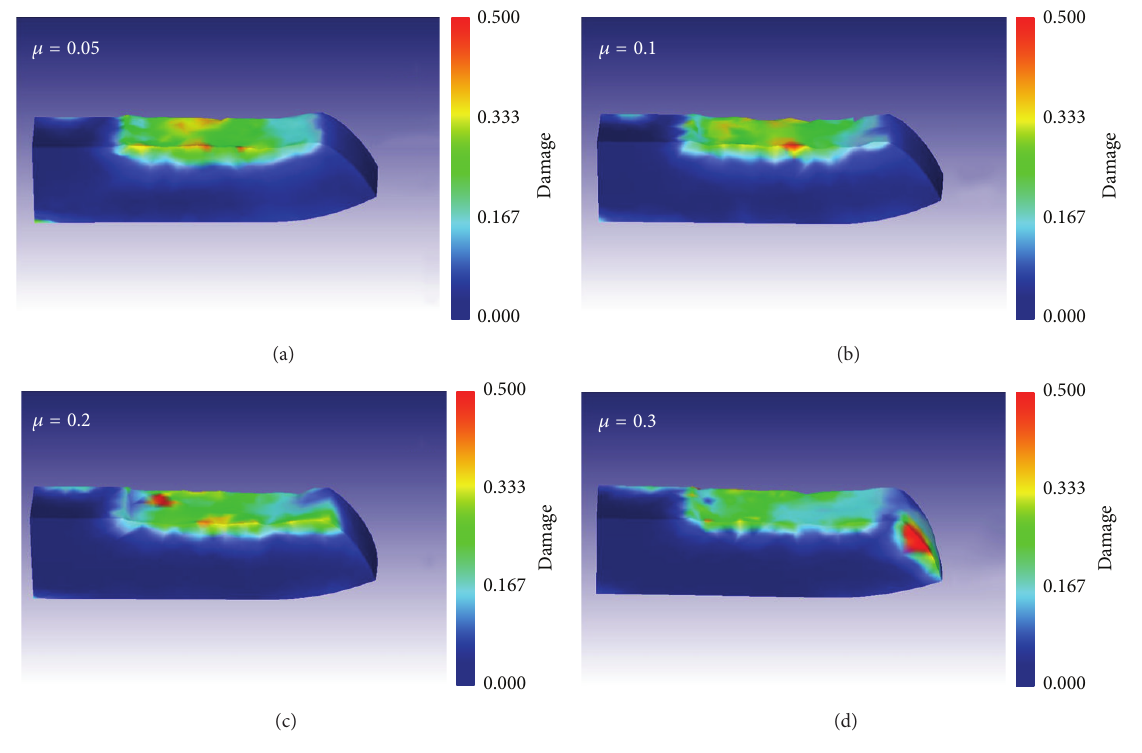
Figure 4: The damage distribution with different friction factor.